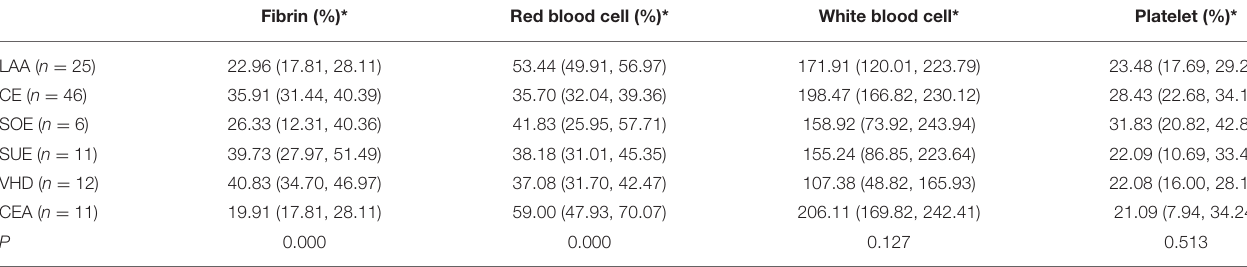
TABLE 3 | Differences in the components among the six